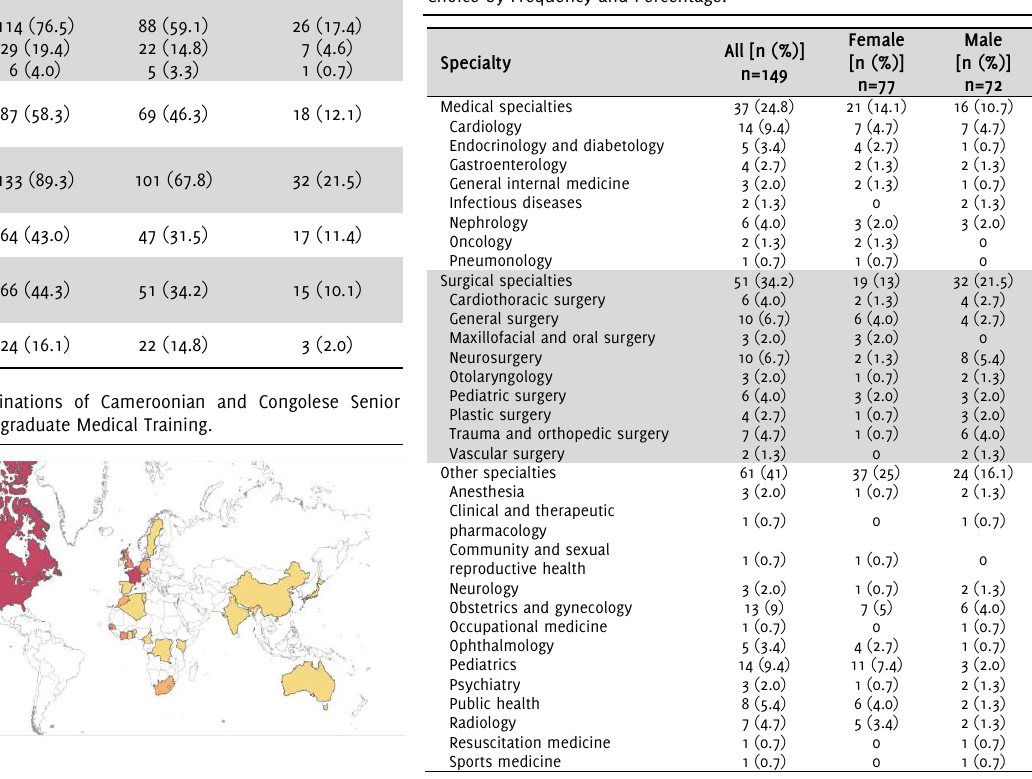
Table 2. Cameroonian and Congolese Medical Students’ First Specialty Choice by Frequency and